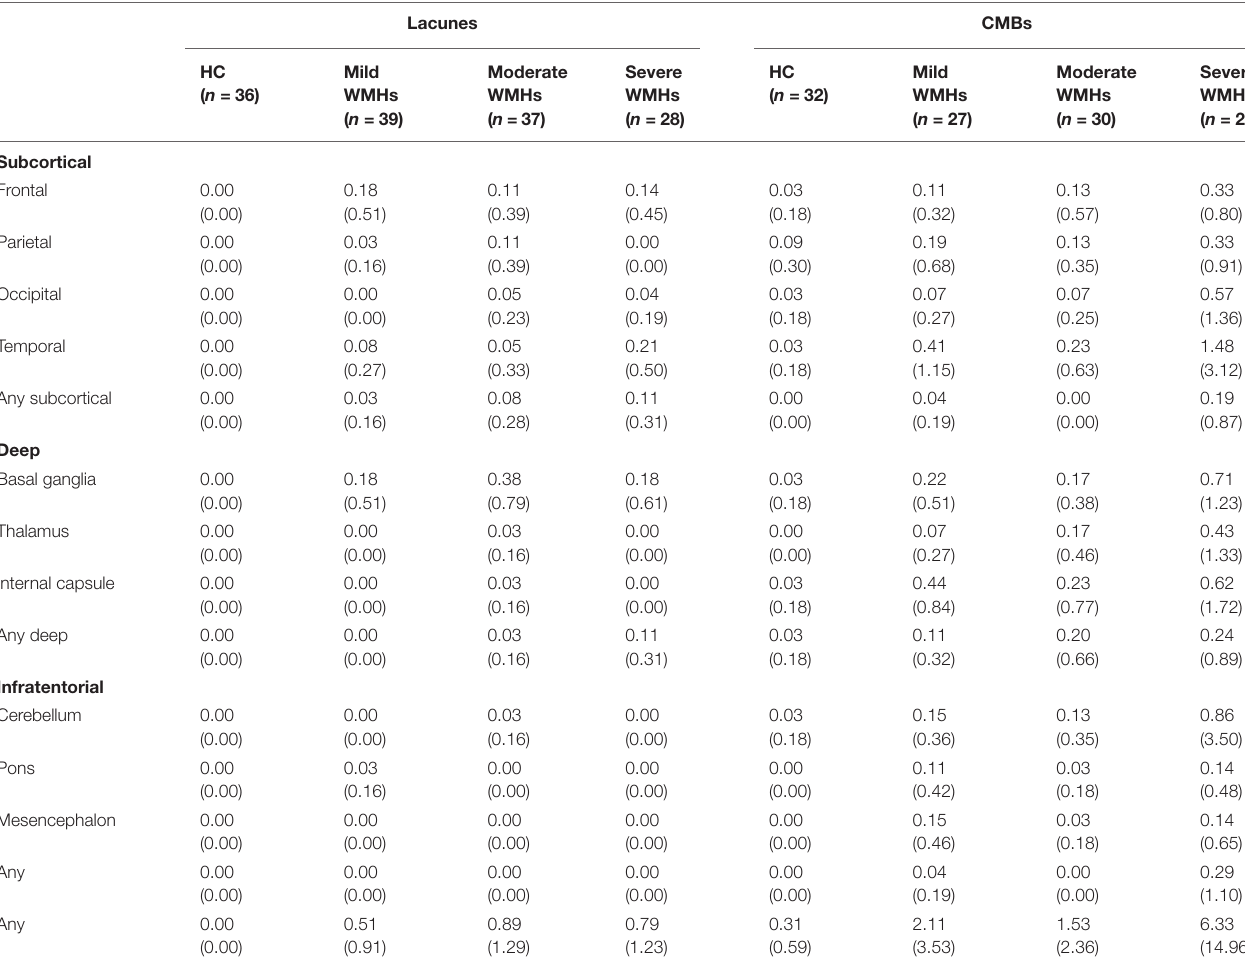
TABLE 2 | Distribution of neuroimaging manifestations in HC and patients with WMHs [mean (SD)]. Lacunes